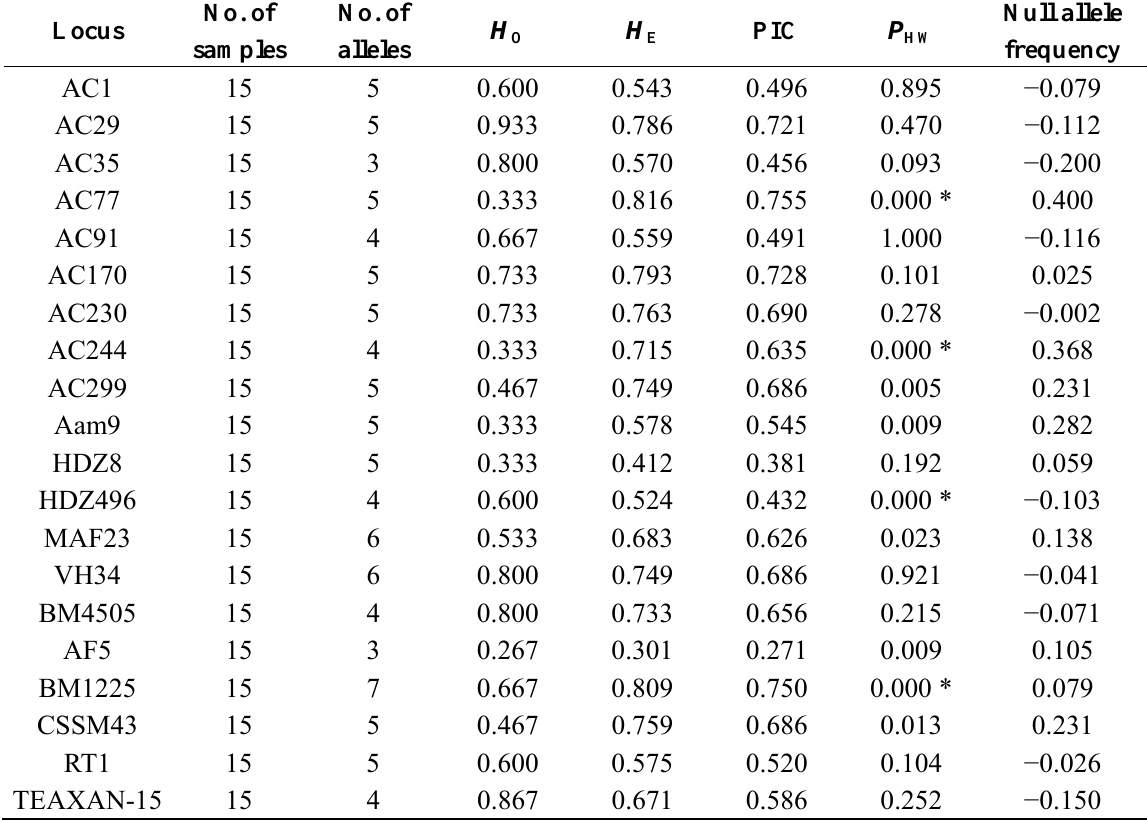
Table 4. Characterization of the twenty cross-species microsatellite loci for P. gutturosa .